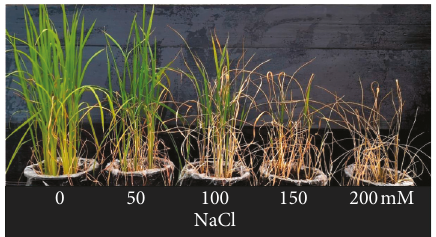
SHR% Clump no./seedling Leaf no./clump Leaf width (cm)